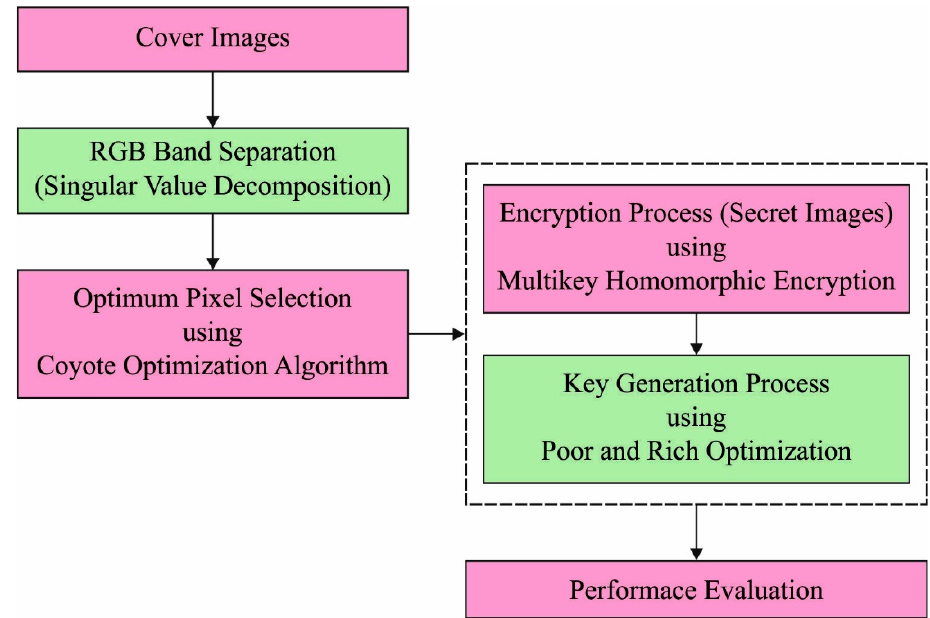
Figure 2. Overall process of OMKHES-MS technique.